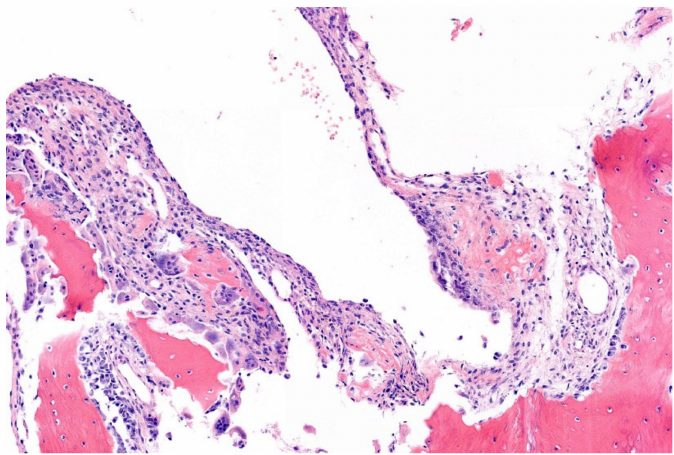
Figure 15. Pseudocystic space of a simple bone cysts lined by myofibroblastic cells. There is primitive